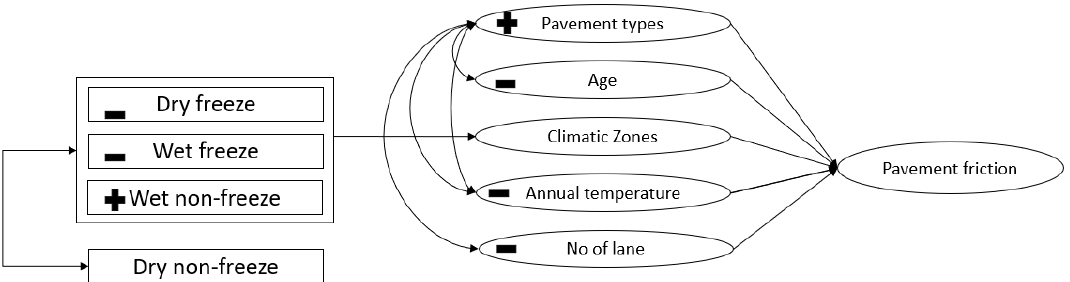
Figure 3. Interrelation structure of factors and friction; − and + are the negative and positive associations with friction, respectively.